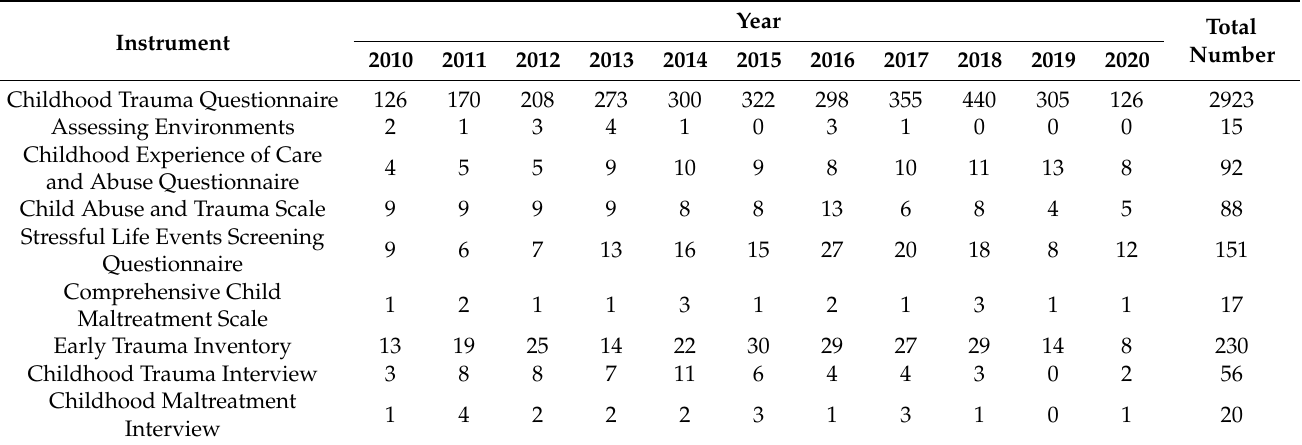
Table 1. Summary of Respective Counts of Different Instruments on